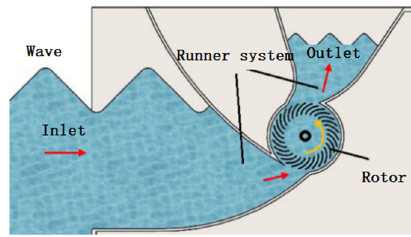
Figure 2. Principle of power generation.